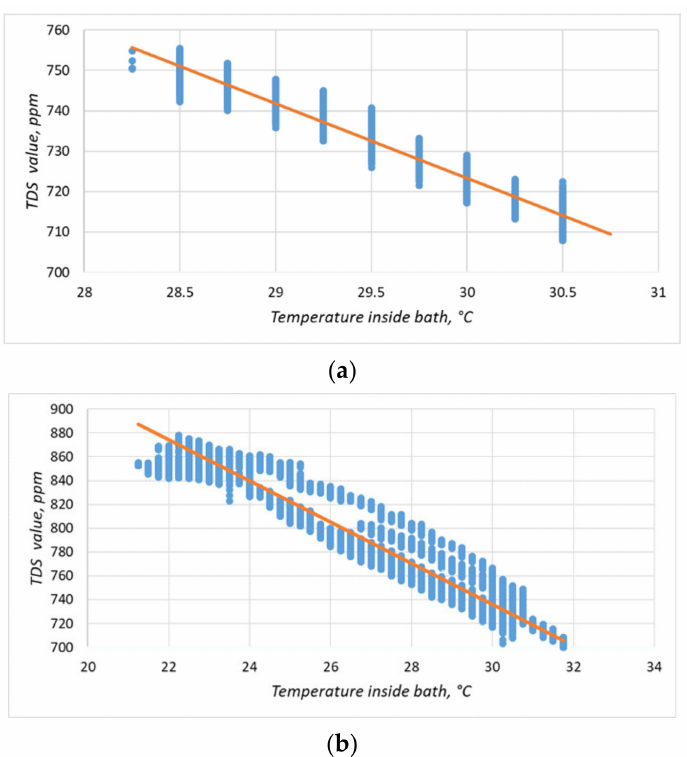
Figure 16. Temperature dependence of the readings of the solids content sensor. The blue dots indicate the experimental data; the orange line is the linearized dependence. The duration of the experiment in ( a ) was 30 min and in ( b ), it was 24